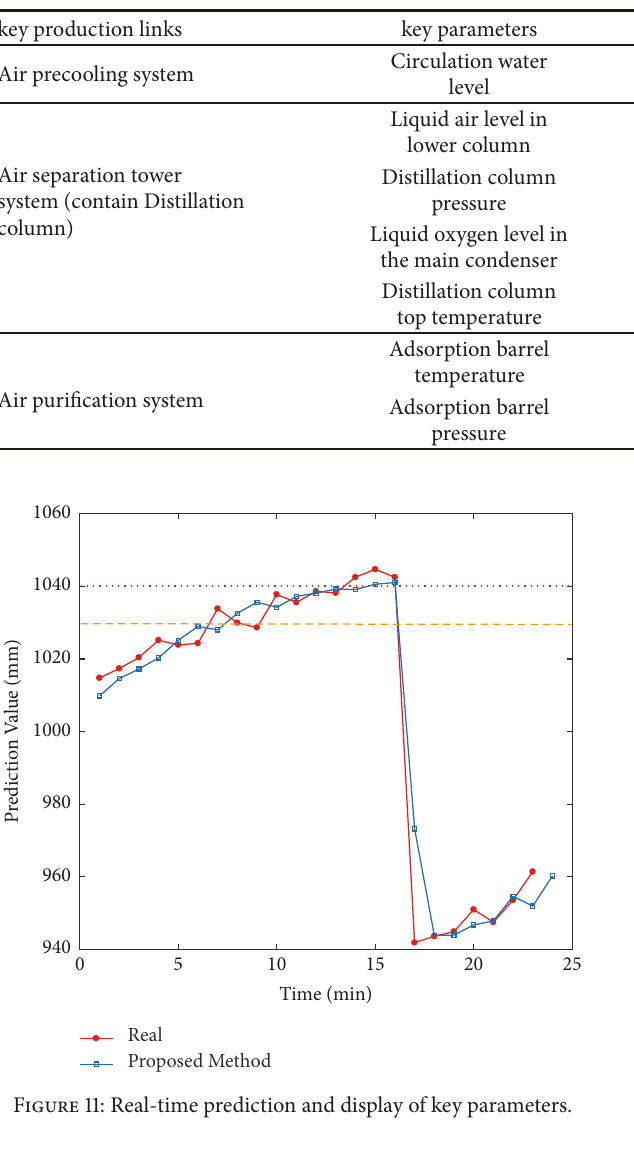
is the number of abnormal after the last time the real value of the key parameter exceeds the high alarm.